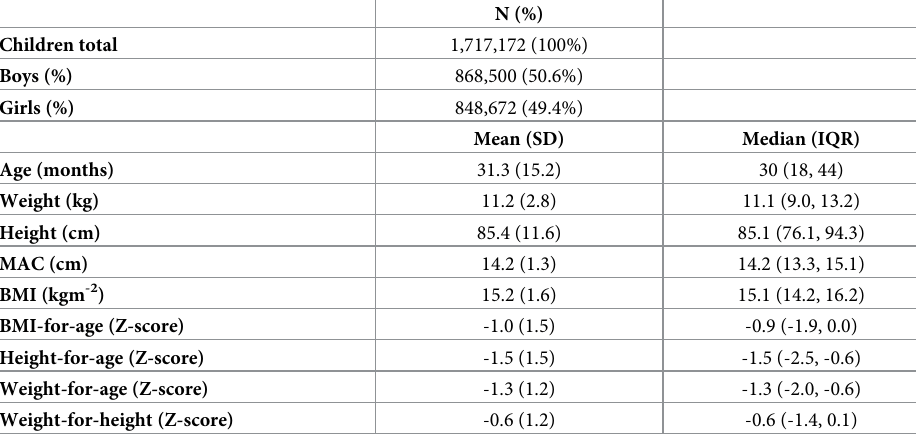
Table 1. Basic demographic information of the children in the